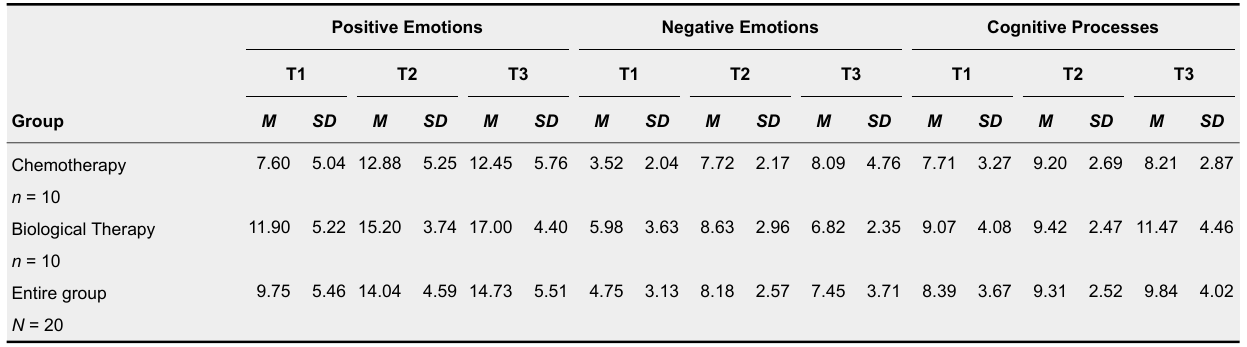
Descriptive Statistics of the Scores of Linguistic Categories (Positive Emotions, Negative Emotions, Cognitive Processes), Reported From Three Writing Sessions (T1-T2-T3) for Biological Therapy, Chemotherapy, and Entire Group